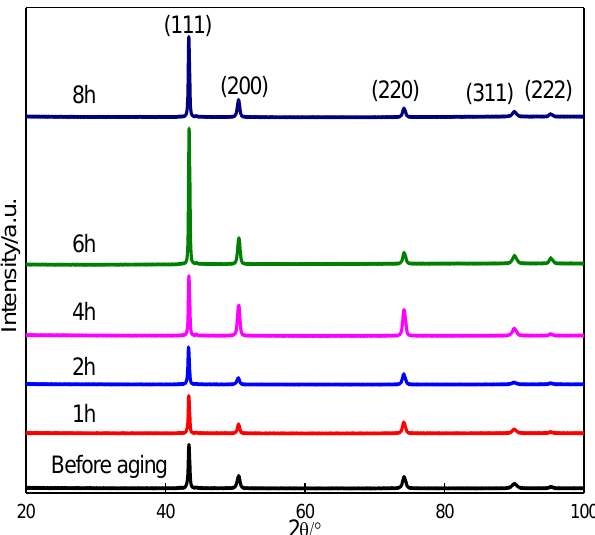
Figure 2. XRD patterns of Cu1.5Cr0.1Si alloy after ECAP by route C and aging at 350 °C for 1 to 8 h.